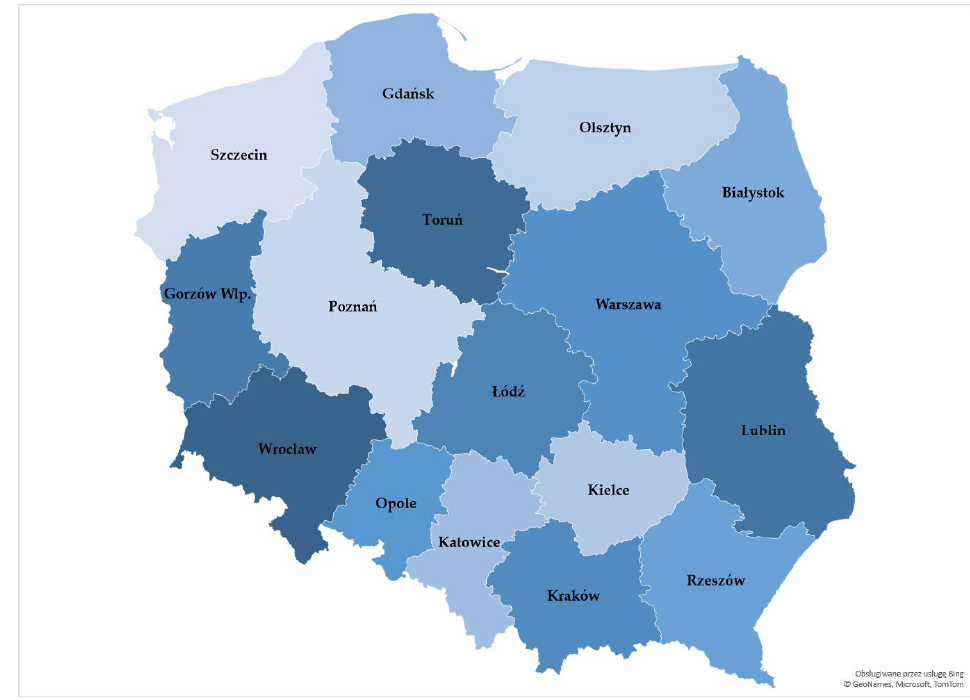
Figure 1. Location of the surveyed cities.